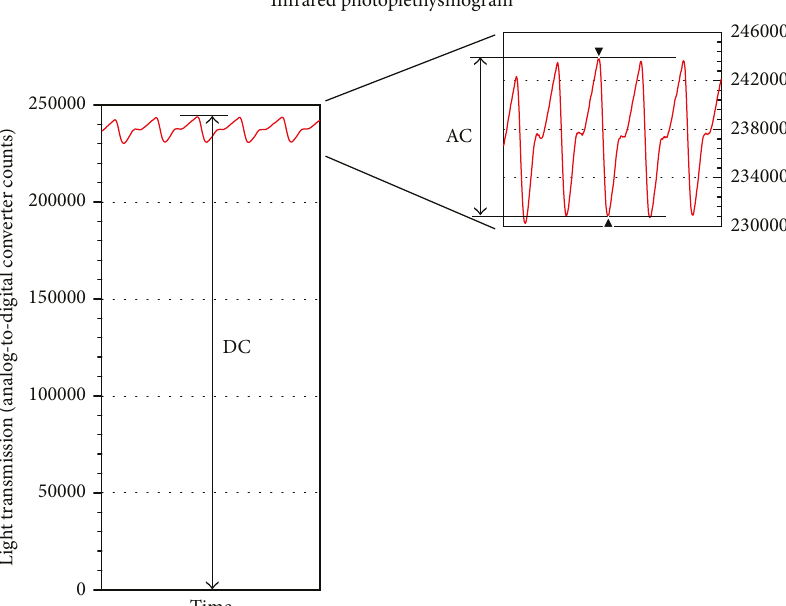
Figure 1: Illustration of photoplethysmogram DC and AC components. The DC value corresponds to the smallest blood volume in the finger (end diastole), which corresponds to the highest light transmission value of each pulse through the finger. The AC values correspond to the difference between the highest (end diastole) and lowest (end systole) light transmission values of each pulse representing the pulse added volume of blood in the finger. Units for the photoplethysmogram DC and AC components are analog-to-digital converter counts that are proportional to the light transmission in